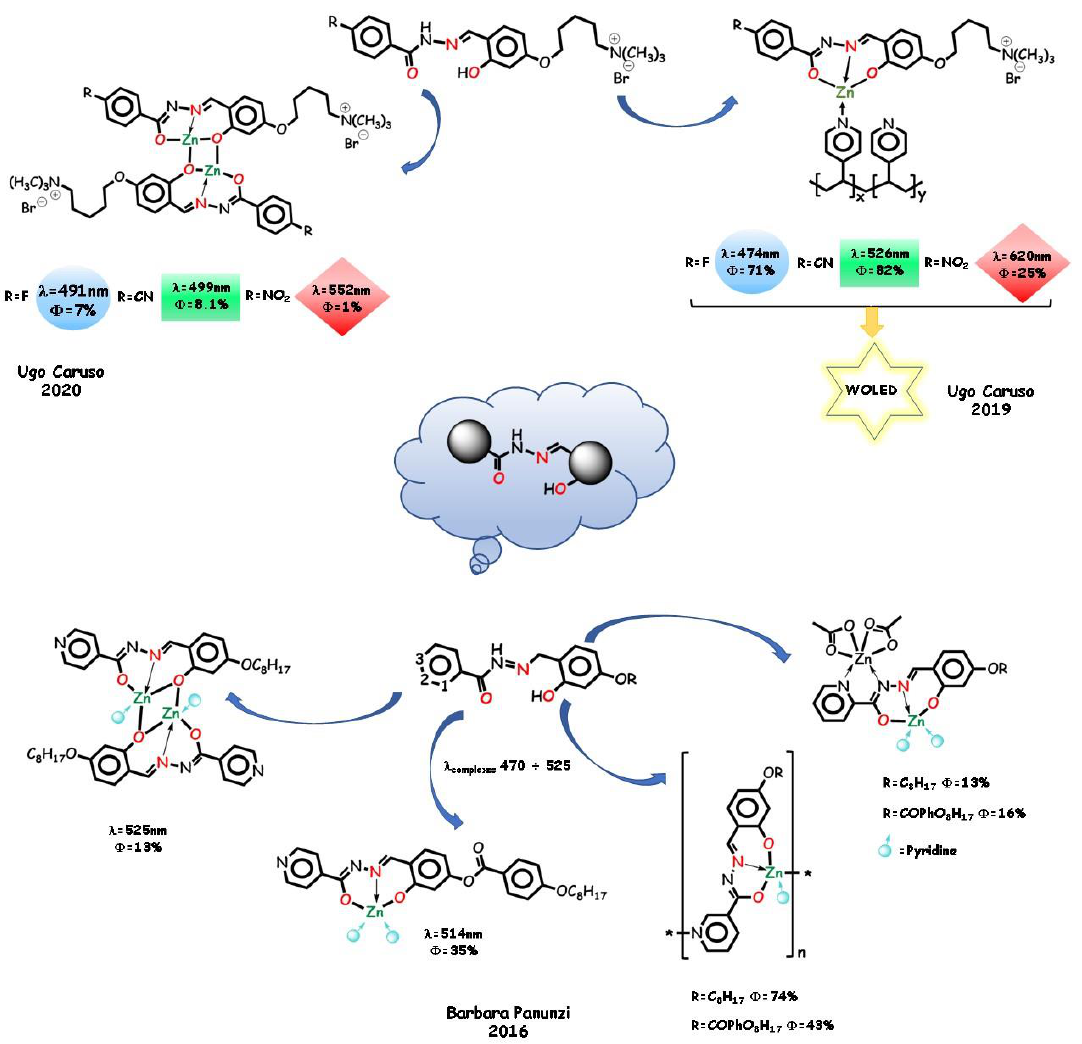
Figure 10. O , N , O aryl-hydrazone ligands with a cationic chain and their zinc polymers. Aroylhydrazone ligands with orto, meta, para pyridinoyl moiety.